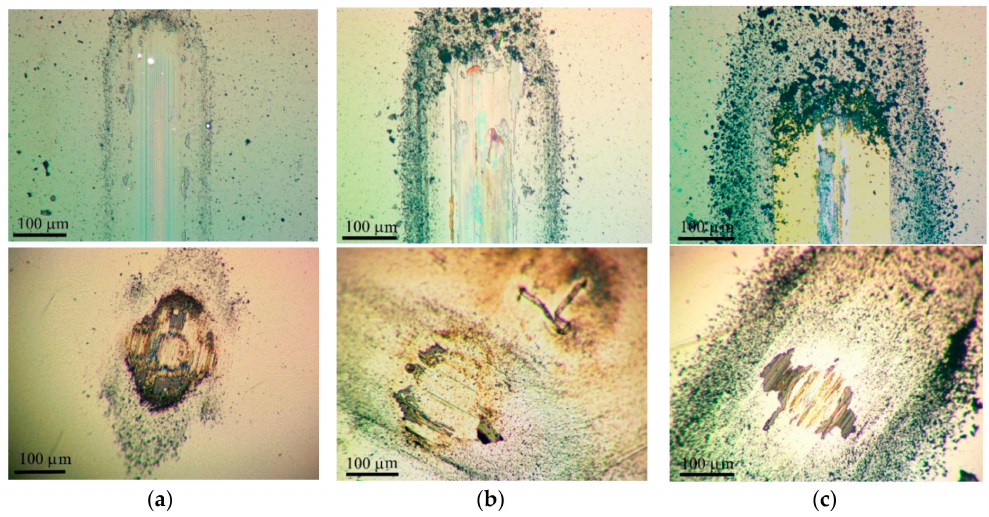
Figure 9. Optical images of wear tracks and wear scars formed on the steel substrates and steel balls for the Mo–S–C–H thin-film coatings obtained by reactive PLD at the di ff erent pressures of H 2 S gas: ( a ) 5.5, ( b ) 9, and ( c ) 18 Pa. Pin-on-disk tribometer testing was conducted in wet friction conditions (RH ~58%) at 22 ◦ C. The test durations are indicated in Figure